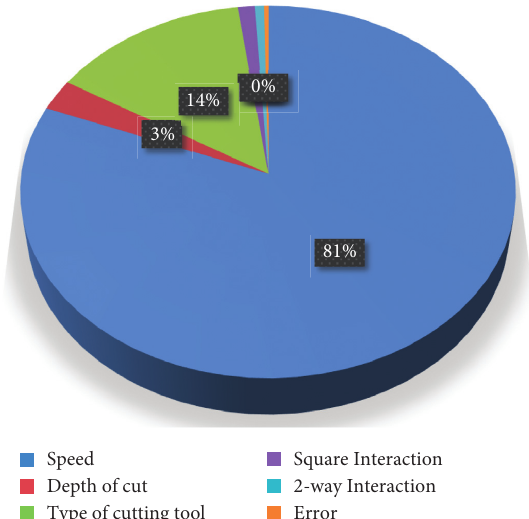
Figure 13: Percentage contribution of the input process parameters and their